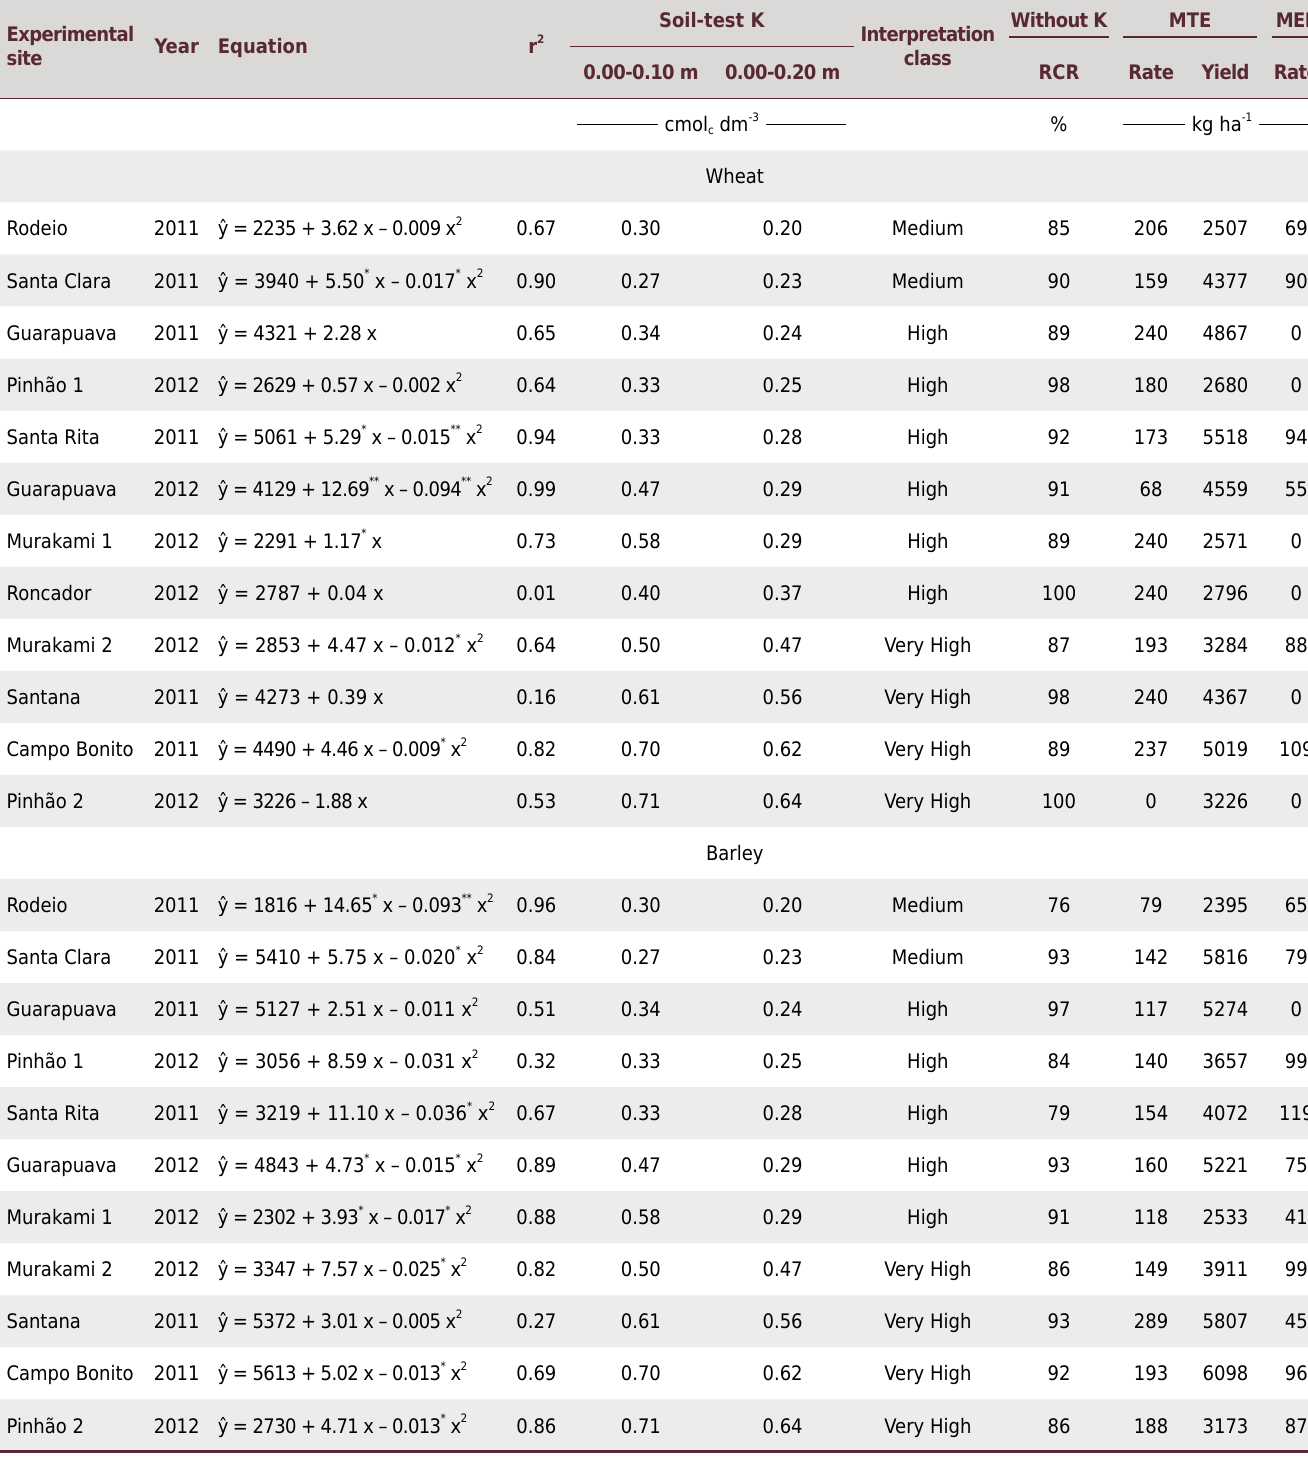
Table 3. Soil-test K values at two soil depths, fitted equations for wheat and barley yields as a function of K rate, relative crop response in the treatment without K, maximum technical efficiency (MTE) rate, and maximum economic efficiency (MEE) rate for different crops and sites Experimental